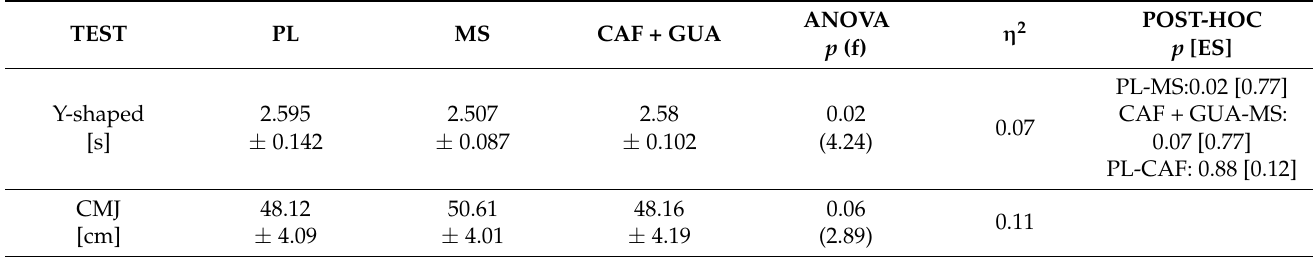
Table 1. Effects of supplementation on reactive agility test and countermovement